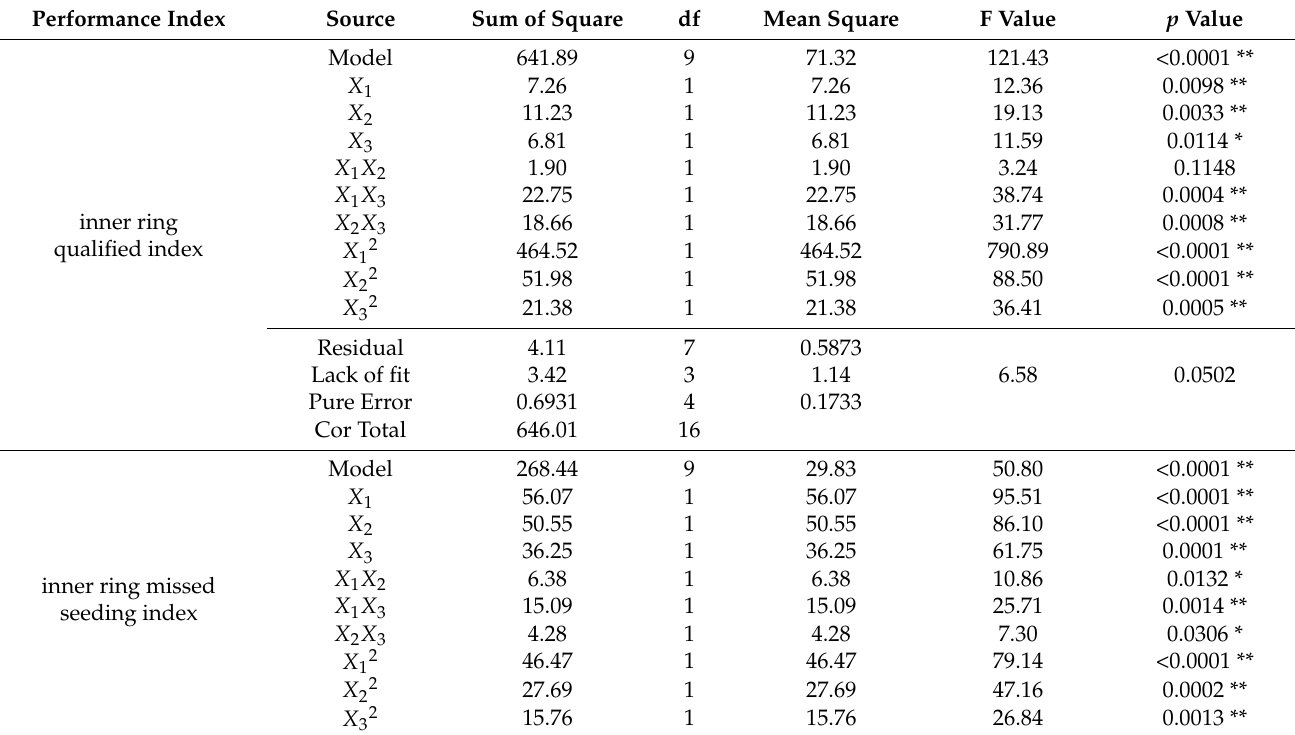
Table 4. Variance Analysis result of inner ring seed-metering performance